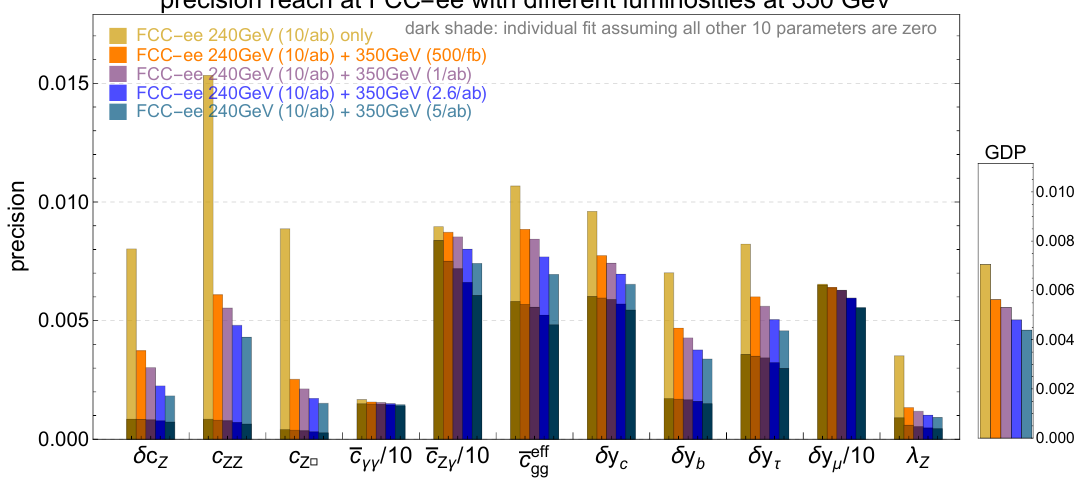
Figure 15 . Same as (cid:12)gure 9 but for FCC-ee with 10 ab (cid:0) 1 at 240 GeV and 500 fb (cid:0) 1 , 1 ab (cid:0) 1 , 2 : 6 ab (cid:0) 1 and 5 ab (cid:0) 1 .